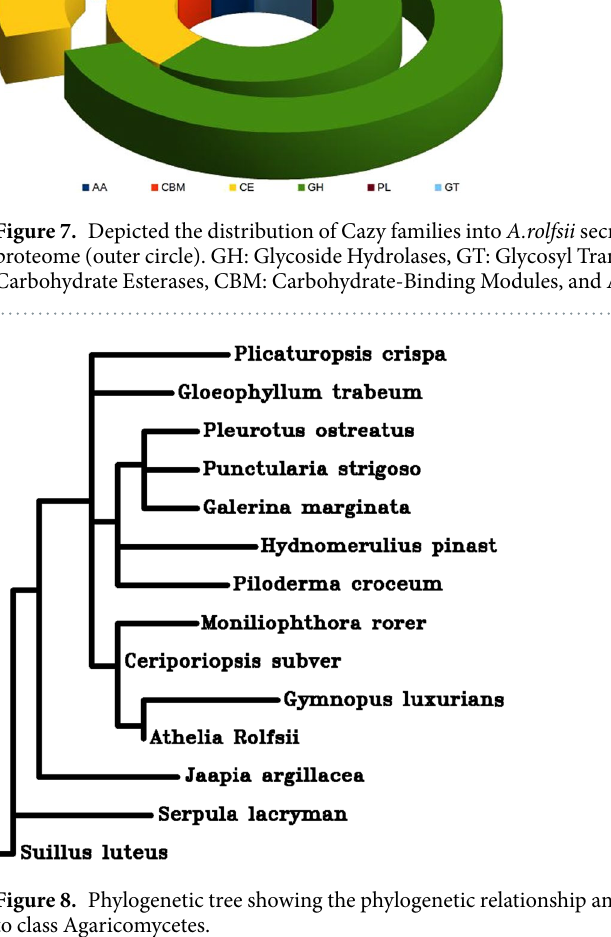
finger CCCH domain-containing protein 62, UDP-glycosyltransferase 76E11, and probable voltage-gated potas- sium channel subunit beta.